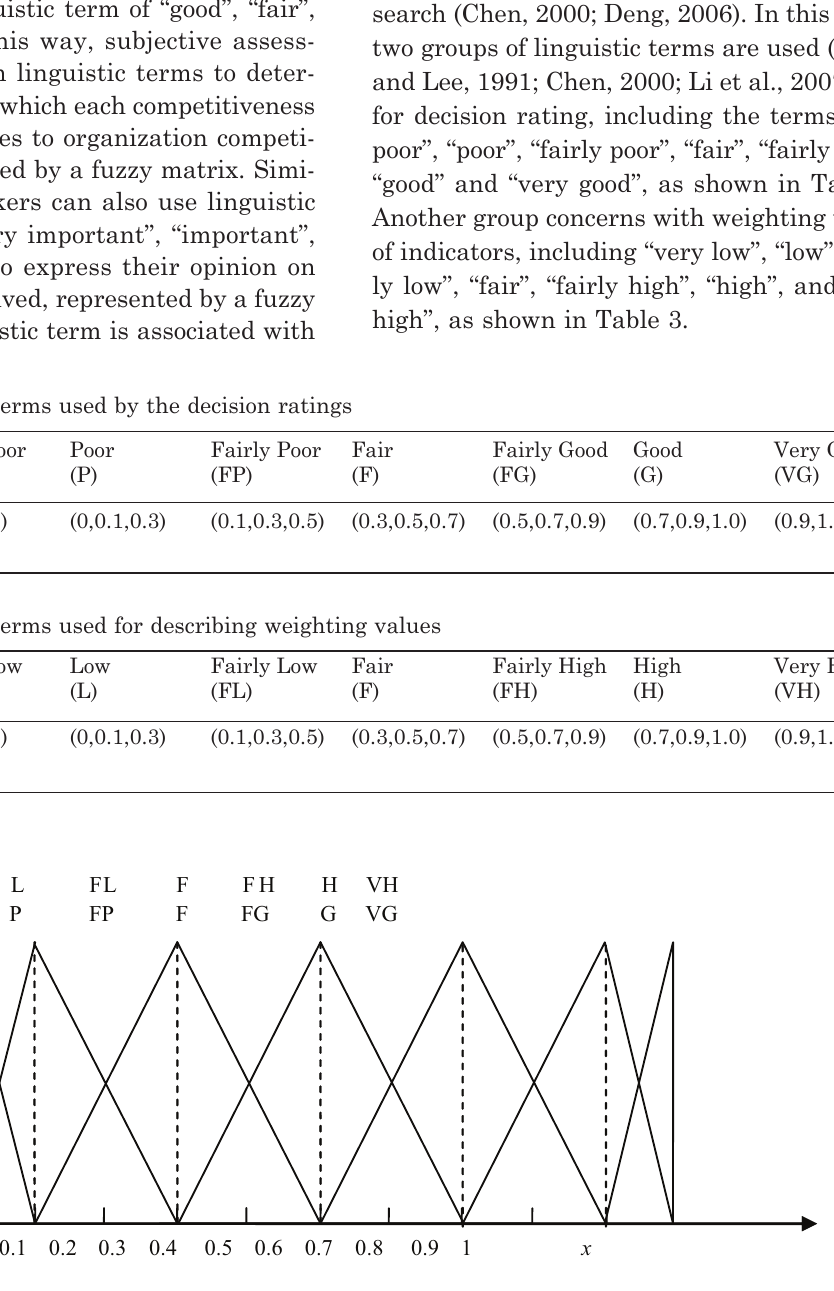
figure 2. Distribution of linguistic terms for ratings and weightings of